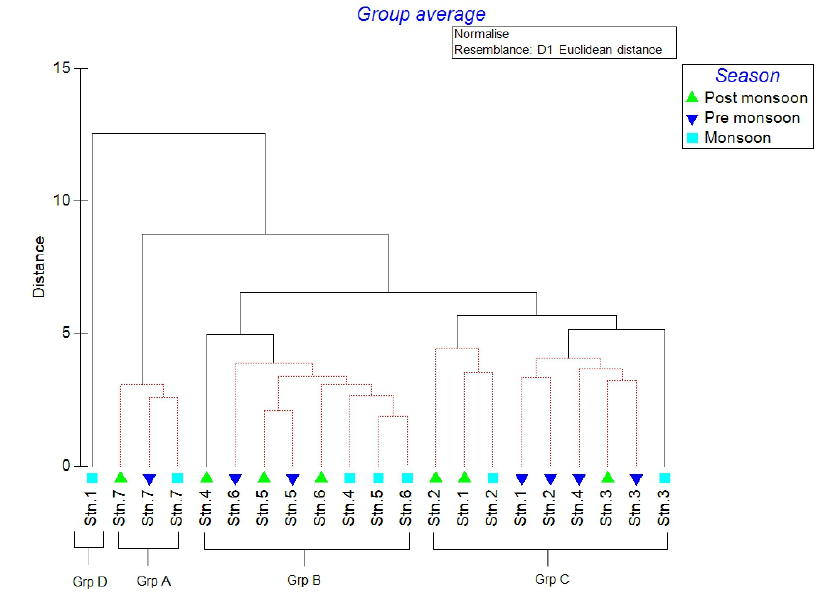
Fig. 2: Cluster dendrogram shows resemblance matrix based on normalized Euclidean distance among stations of Veli-Akkulam and Vellayani